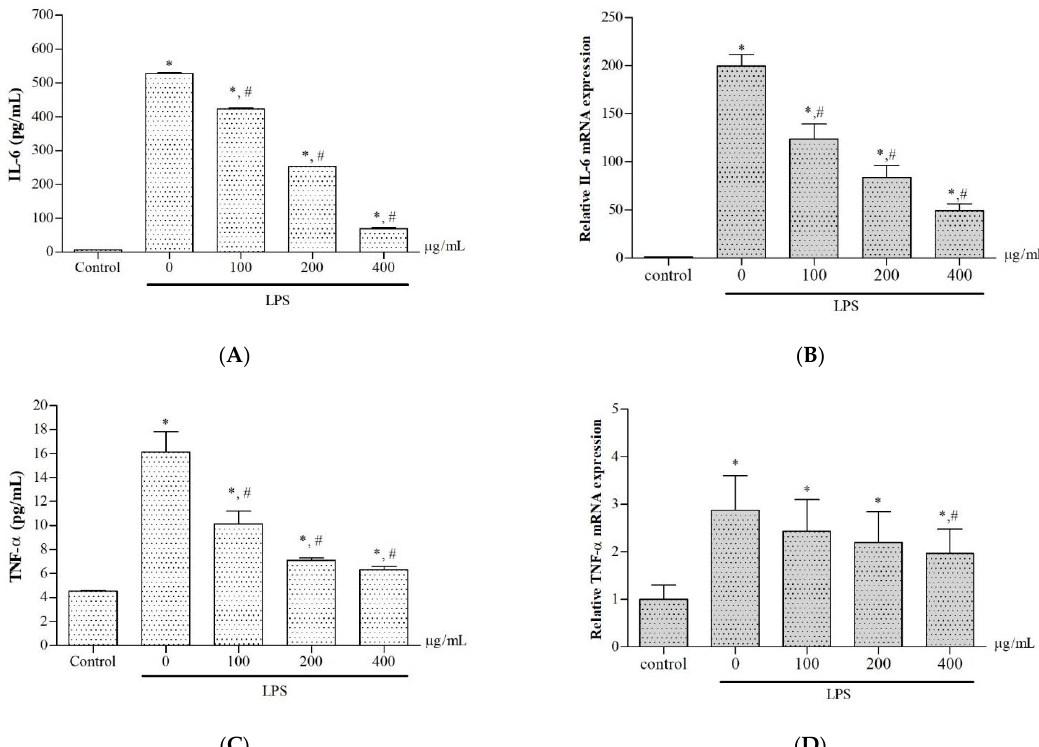
Figure 7. Levels of IL-6 production ( A ) and mRNA expression ( B ), as well as TNF- α production ( C ) and mRNA expression ( D ), in the medium obtained from the cultured RAW264.7 macrophage induced by LPS and treated with 50% ethanolic extract of P. odoratum Lour. cv. Pakphai leaves. Data obtained from three independent experiments are expressed as mean ± SEM values. Accordingly, * p < 0.05 was considered significant when compared to the control cells without LPS induction; # p < 0.05 was considered significant when compared to LPS-induced cells without the extraction treatment. Abbreviations: LPS = lipopolysaccharide, SEM = standard error of the mean values, TNF- α = tumor necrotic factor-alpha.